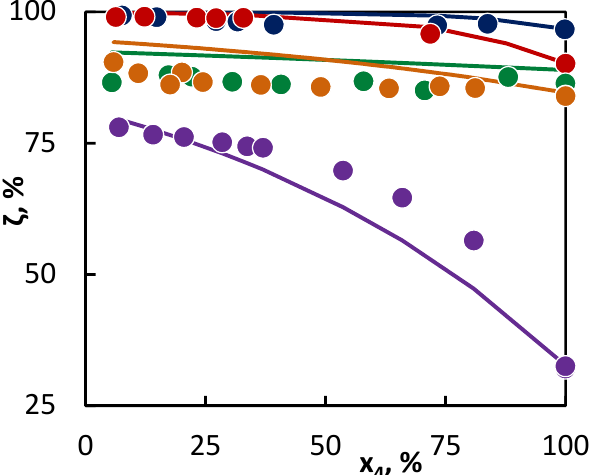
Figure 1. Co-pyrolysis of C4 hydrocarbons and hexane: conversion of C4 hydrocarbons ( ● 1-butene; ● 2-butene; ● isobutane; ● butane; and ● isobutene) in dependence on their mole fraction in the binary mixture. Points represent experimental data and lines were obtained from regression